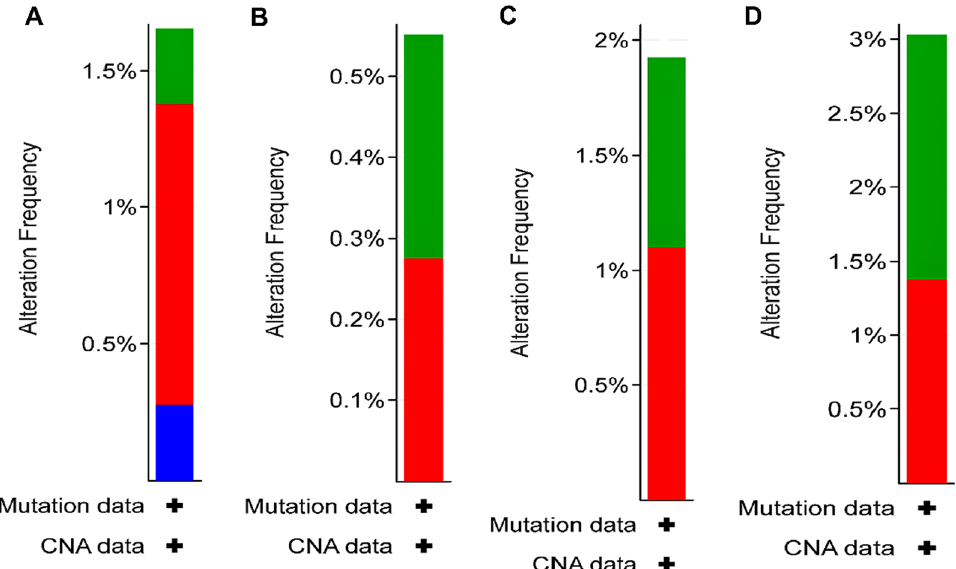
Fig. 7 Barplots showing alteration frequencies of A APLN, B ALDH2, C E2F1, and D PCK1 across TCGA-HCC cohort. Red, blue, and green colored bars signify amplifications, deep deletions, and missense